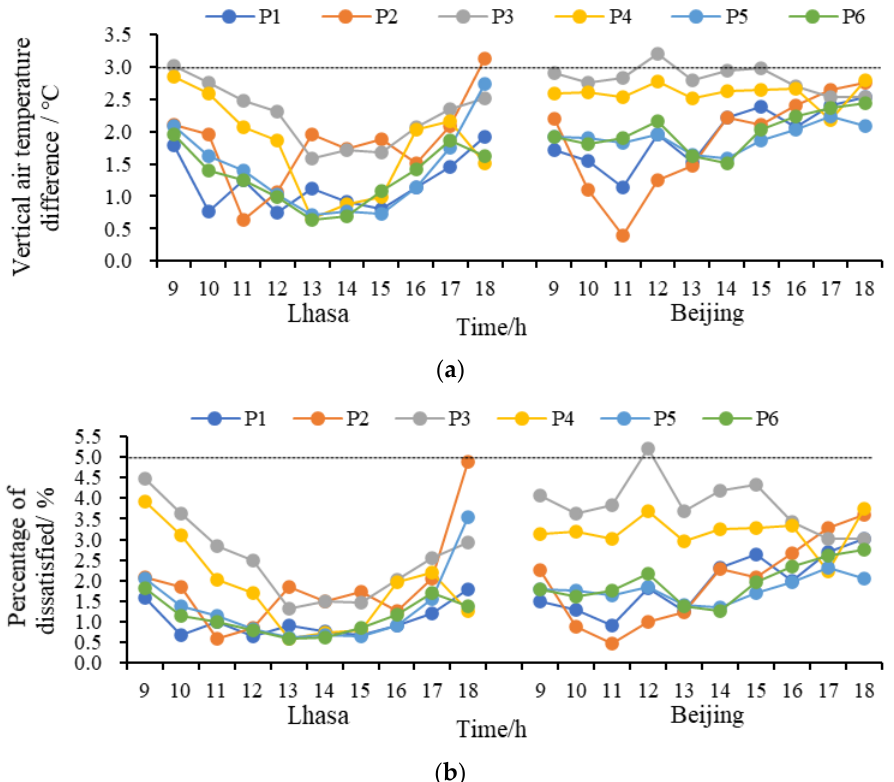
Figure 15. Diurnal variations of VATD: ( a ) vertical temperature differences; ( b ) percentage of dissatisfied.